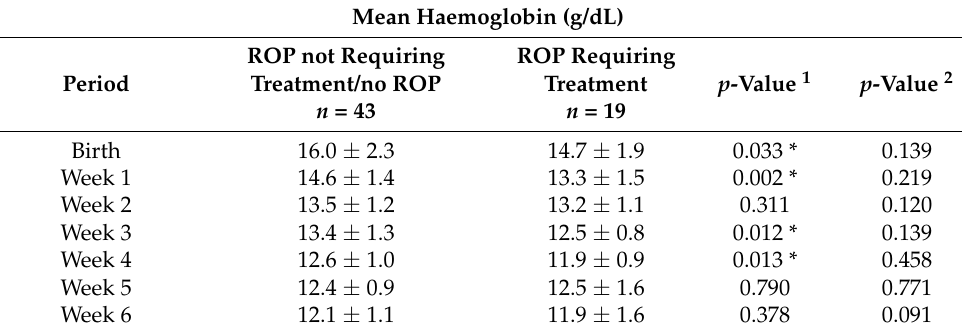
Table 3. Weekly mean haemoglobin levels based on the need for treatment of